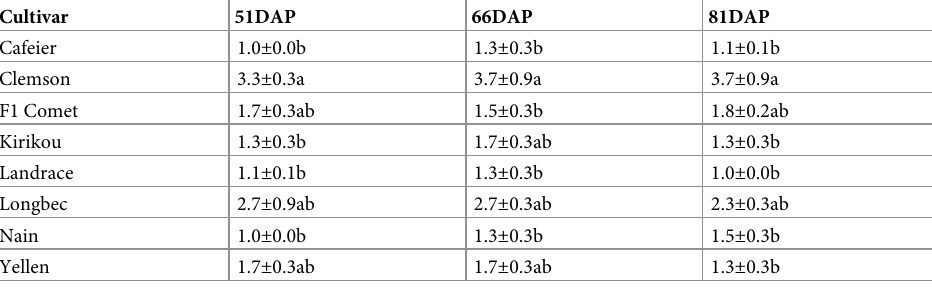
Values with the same letter in a column are not significantly different from each other under Tukey test at a 5% probability level.